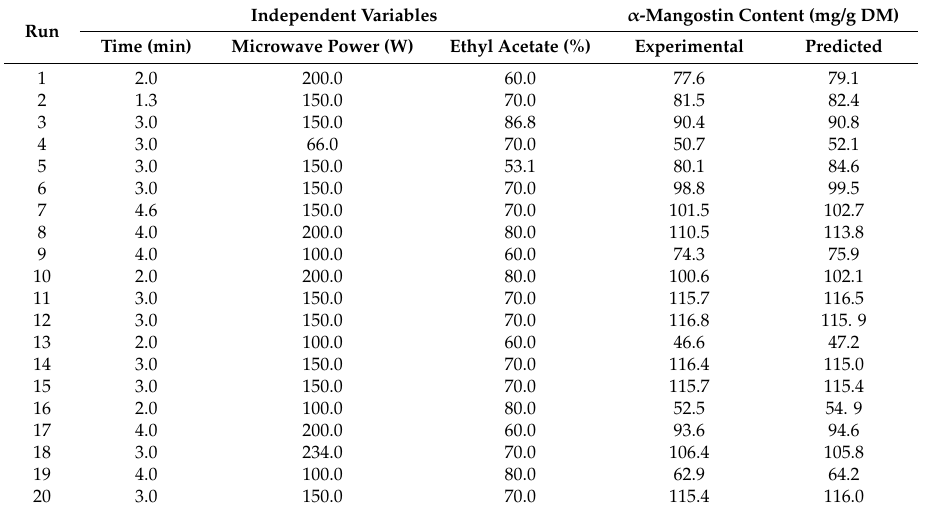
Table 1. The experimental design and response of three independent variables on α -Mangostin content.